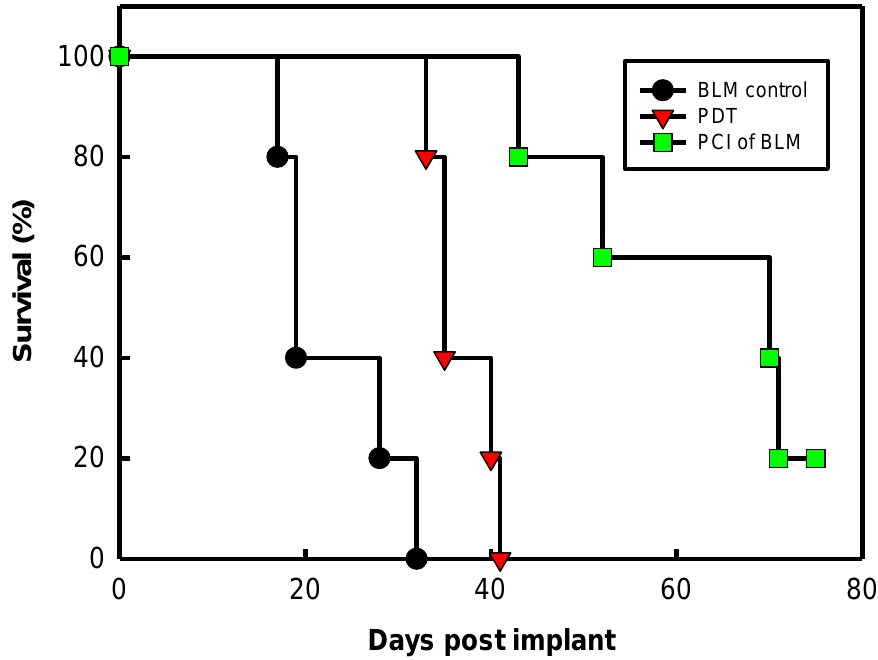
Figure 6. Treatment protocol and Kaplan–Meier survival of tumor cell implanted animals. All animals received 1 x 10 4 cells i.c. Three groups were followed: Control (BLM (bleomycin) 8 mg / kg), PDT-BLM (AlPcS 2a 1J), Clp-PCI BLM (AlPcS 2a , Clp, 1 J); BLM 8 mg / kg was injected i.p. twice daily for 3 days after light exposure. Reproduced from Hirschberg et al. [225].